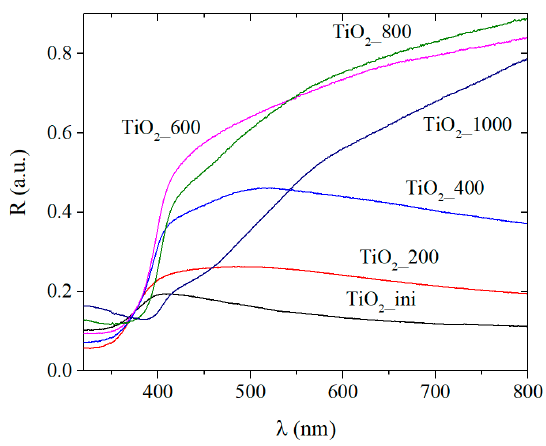
Figure 6. UV-Vis spectra of titania powder.